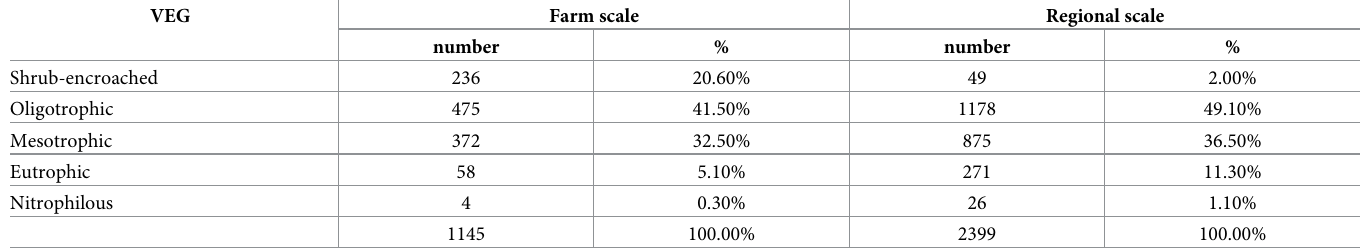
Table 2. Count and relative percentage of the sample units and vegetation surveys retained for the five Vegetation Ecological Groups (VEG) at farm and regional scale, respectively.